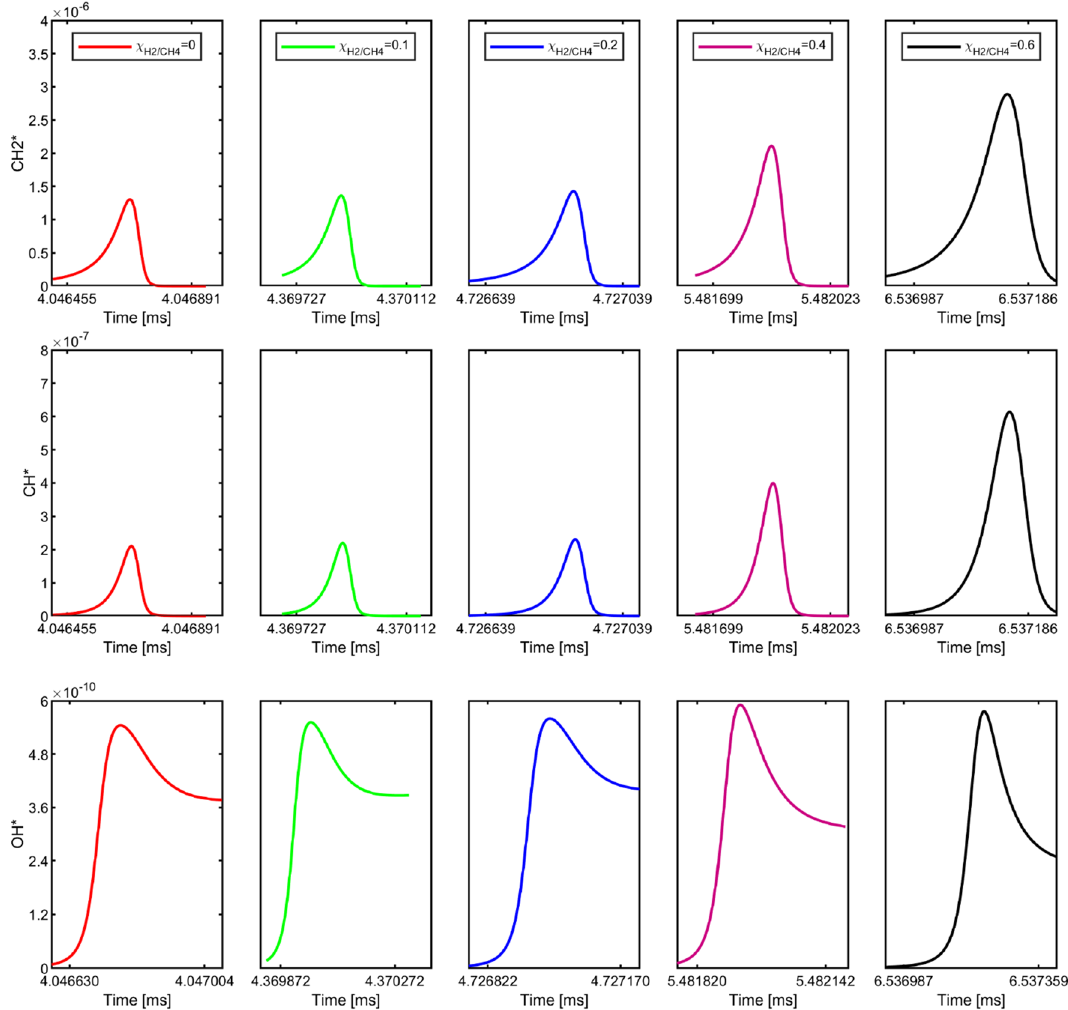
Figure 13. The excited species concentration profiles of n-dodecane/CH 4 /H 2 /Air mixture combustion at different χ H 2 / CH 4